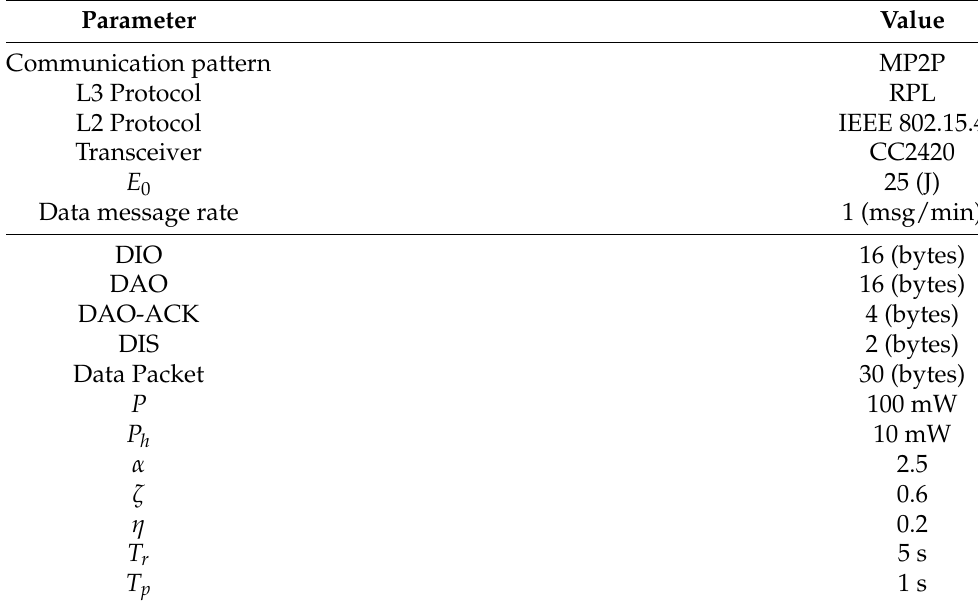
Table 2. Parameters adopted in performing numerical